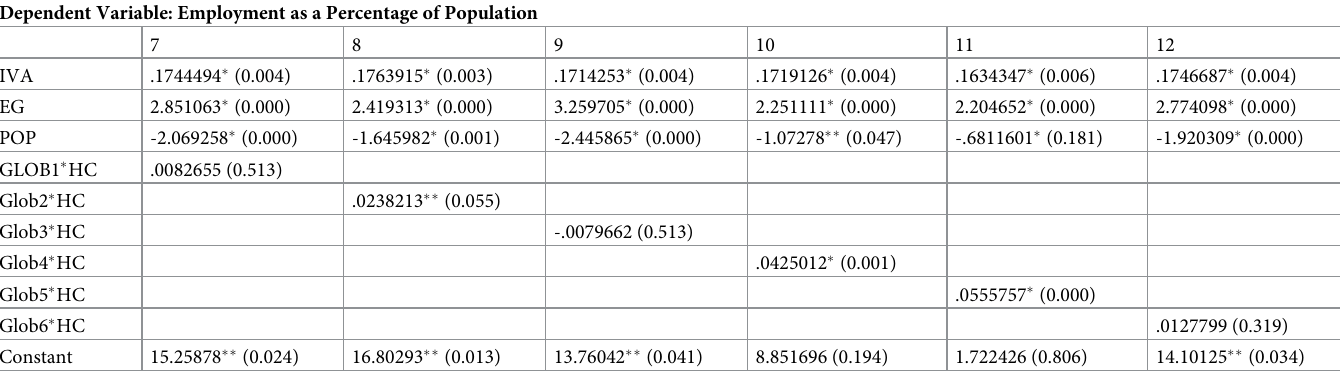
Table 9. Indirect impact of globalization on employment through human capital